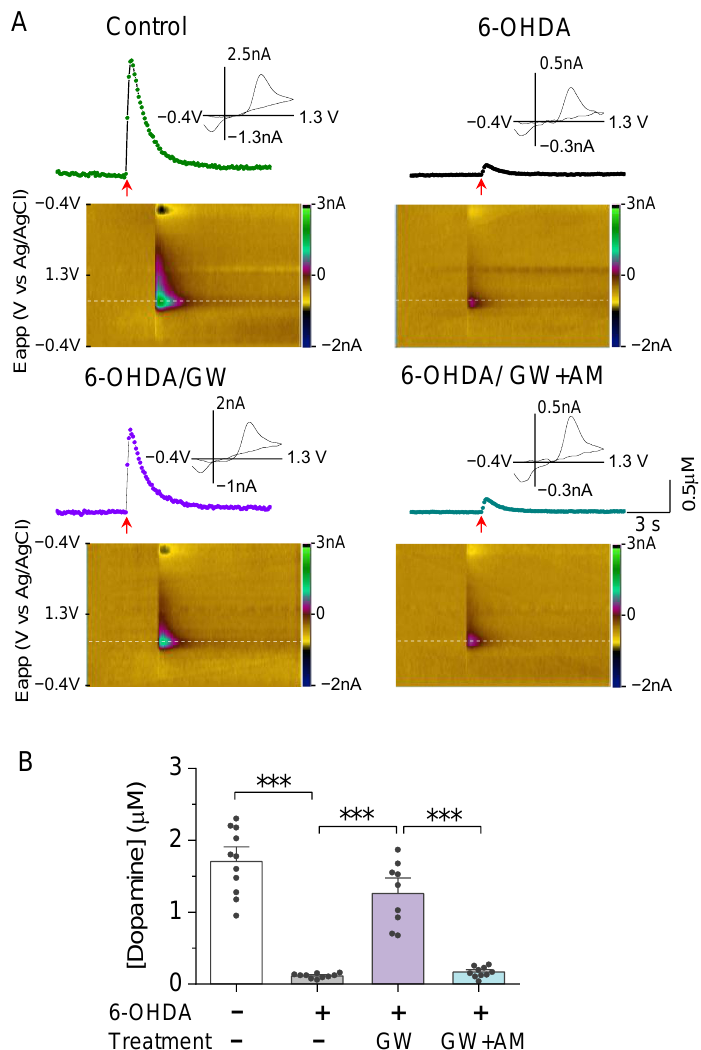
Figure 3. GW protected against 6OHDAinduced loss of evoked dopamine release in the NAc in vitro. ( A ) Concentration trace (top) and color plot (bottom) for dopamine release triggered by electrical stimulation of the NAc shell in slices from mice in the control and treatment groups. ( B ) Summarized data indicate that there was a significant decrease in evoked dopamine release in the 6-OHDA group relative to the control (*** p < 0.001; n = 10–11 slices from 3–4 mice). Chronic treatment with GW reduced 6-OHDA-induced loss of evoked dopamine release (*** p < 0.001; n = 9–10 slices from 3–3 mice), which was blocked by AM (*** p < 0.001; n = 9–10 slices from 3–3 mice).